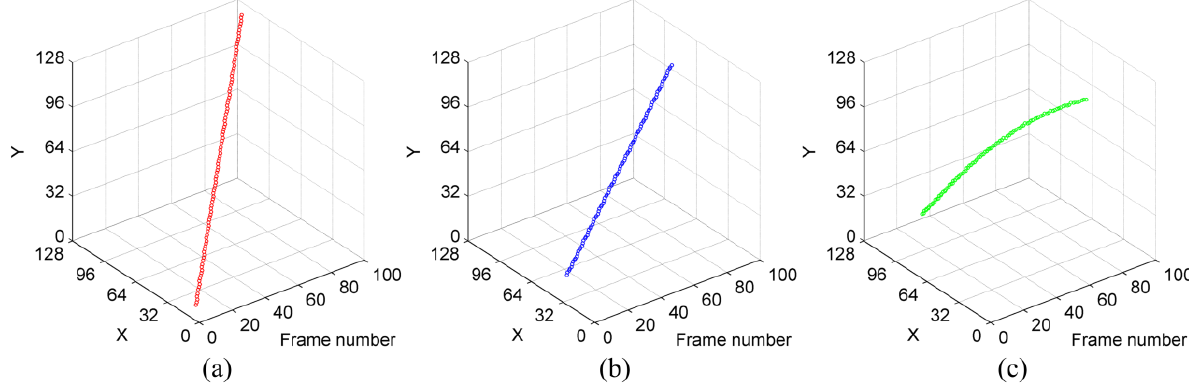
Figure 5. ( a ) Test case 1; parameters of the straight-line trajectory were as follows: initial coordi- nates were (5, 10) and motion velocity was (1.2, 1.1) pixel/frame; ( b ) test case 2; parameters of the straight-line trajectory were as follows: initial coordinates were (30, 20) and motion velocity was (0.6, 0.8) pixel/frame; ( c ) test case 3; parameters of the arc trajectory were as follows: motion speed was 1 pixel/frame, arc center coordinates were (64, 64), and arc diameter was 20 pixels.